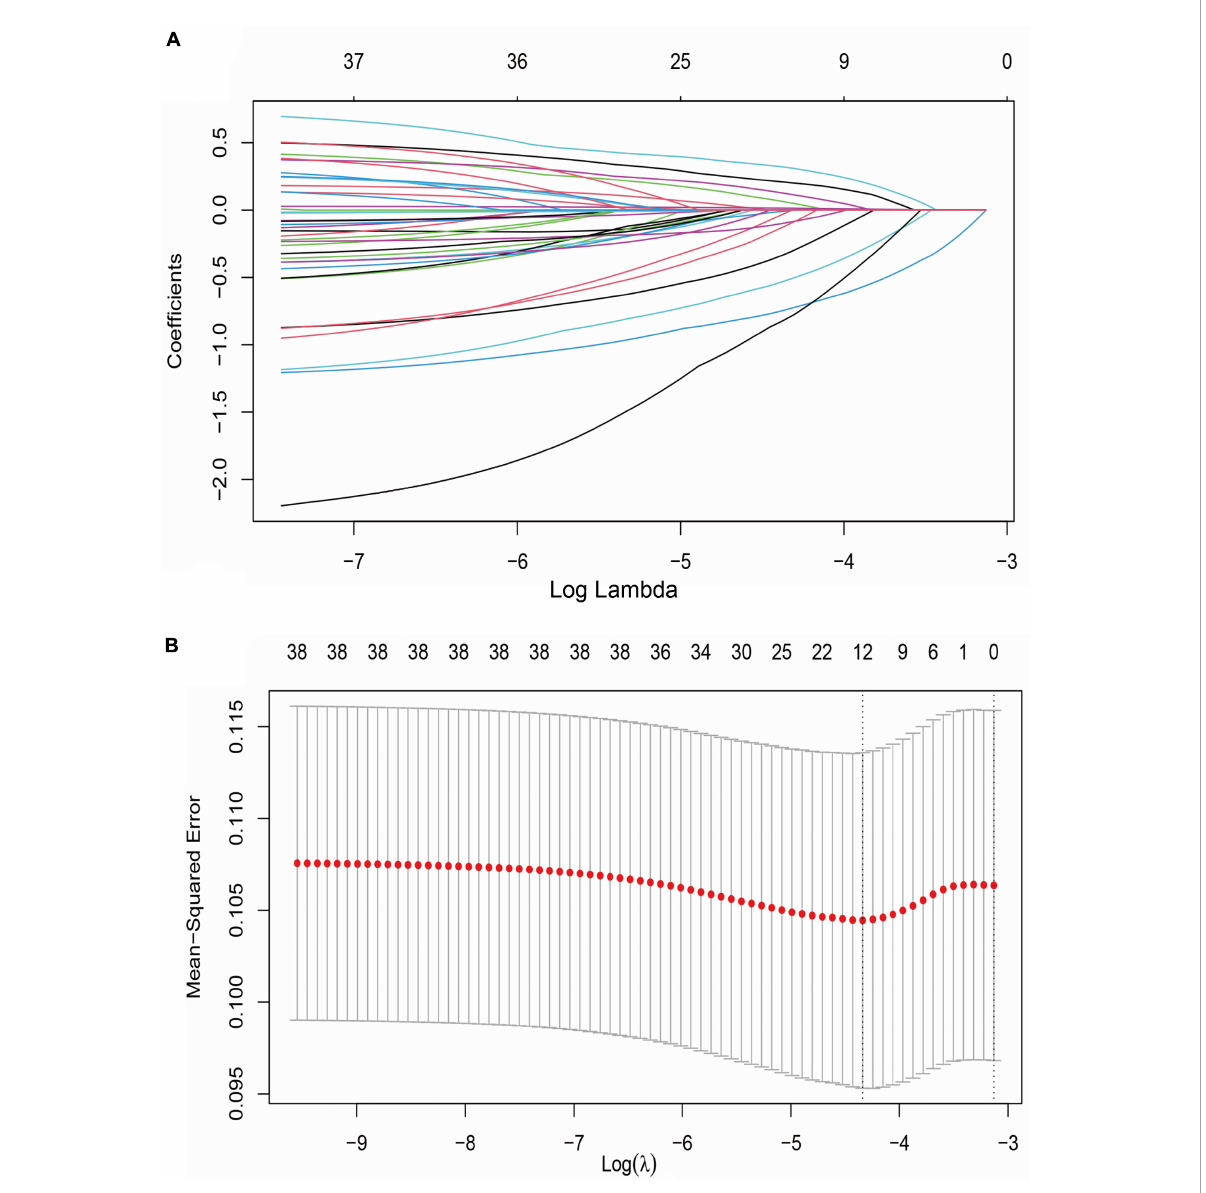
FIGURE3 LASSO regression analysis for variable selection. (A) LASSO coefficient of 38 variables; (B) optimal penalty coefficient ( λ = 0.000584) in LASSO regression identified with the minimum criterion; LASSO, least absolute shrinkage and selection operator; SE, standard error.